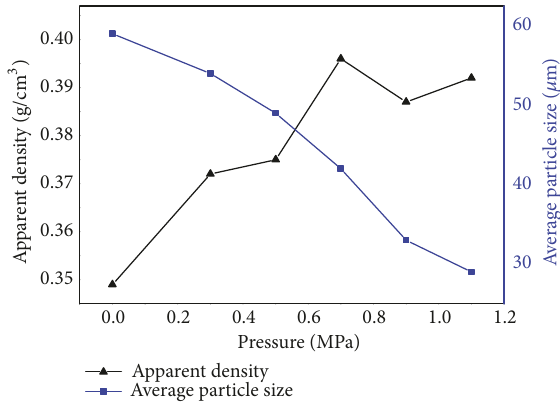
Figure 3: Plots of average particle size diameter and apparent den- sity of PP powders versus pressure (dissolution temperature166 ∘ C, solid-to-solvent ratio 0.067